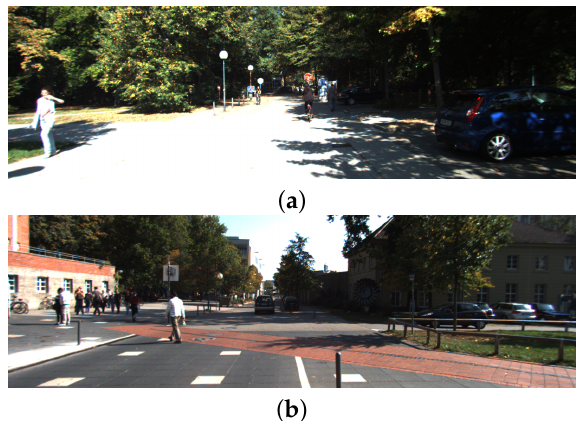
Figure 4. Scenario optical images: ( a ) 0047 and ( b ) 0016